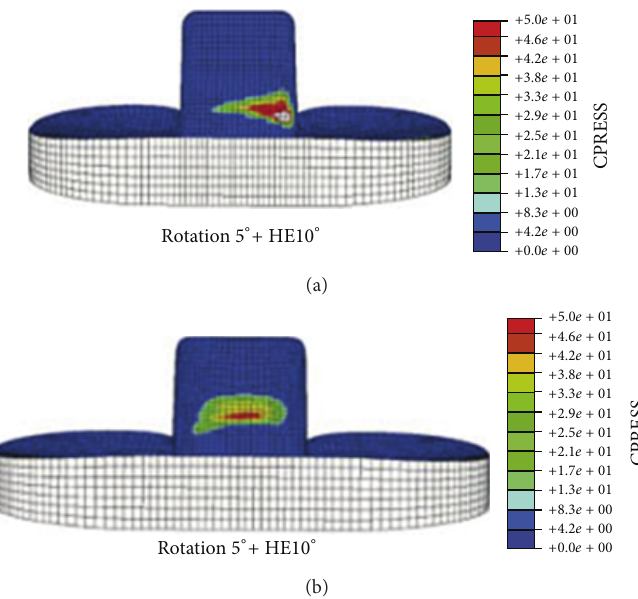
Figure 3: Contact stress (MPa) on the anterior face of tibial post at 10 ∘ hyperextension and 5 ∘ axial rotation for (a) flat-on-flat and (b) curve- on-curve contact surfaces (modified from